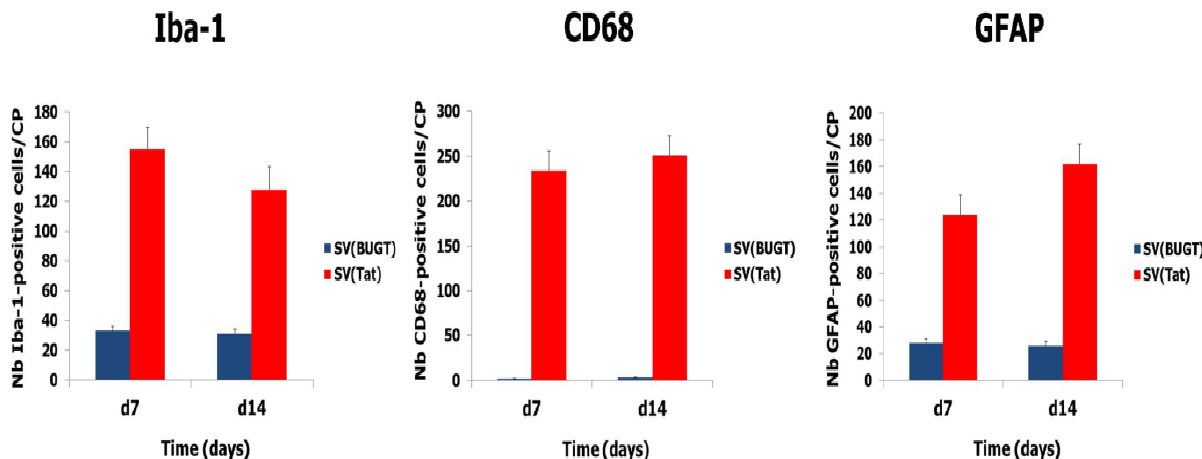
Table 1. Table showing the changes in the caudate-putamen (CP) of rat following injection of SV(Tat). More numerous Tat-positive cells and TUNEL-positive cells were seen one month after injection of SV(Tat) in the CP ( p < 0.01: SV(Tat) vs. SV(BUGT)). Neuronal loss was observed ( p < 0.01: SV(Tat) vs. SV(BUGT)). An increase in the level of MDA, suggesting of oxidative stress, was also detected ( p <